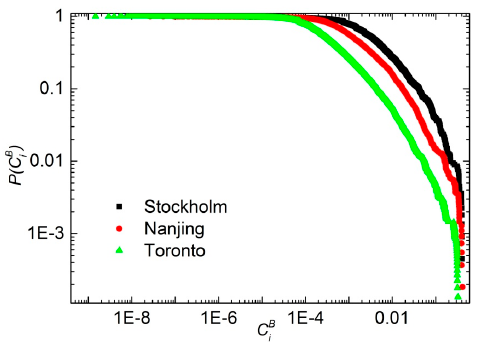
Figure 7. Cumulative probability distributions of betweenness centrality of: Stockholm, Nanjing, and Toronto.